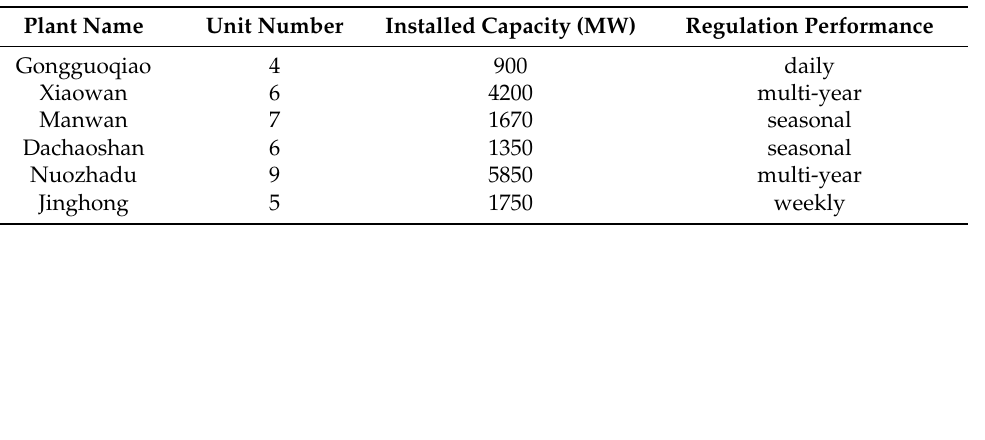
Table 1. Basic characteristics of hydropower